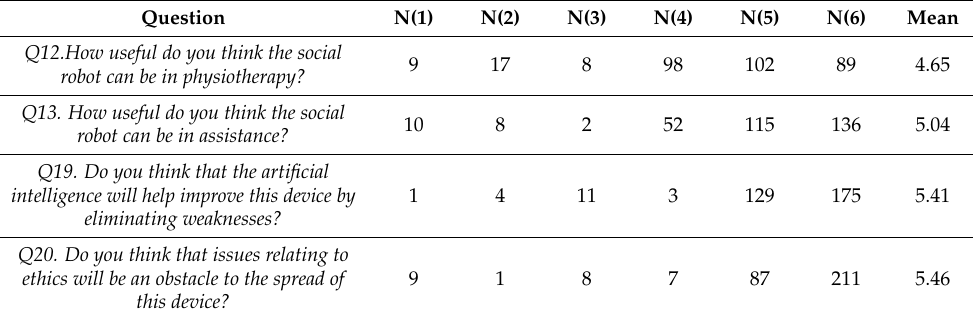
Table 2. Results relating to the graded questions with the details of the